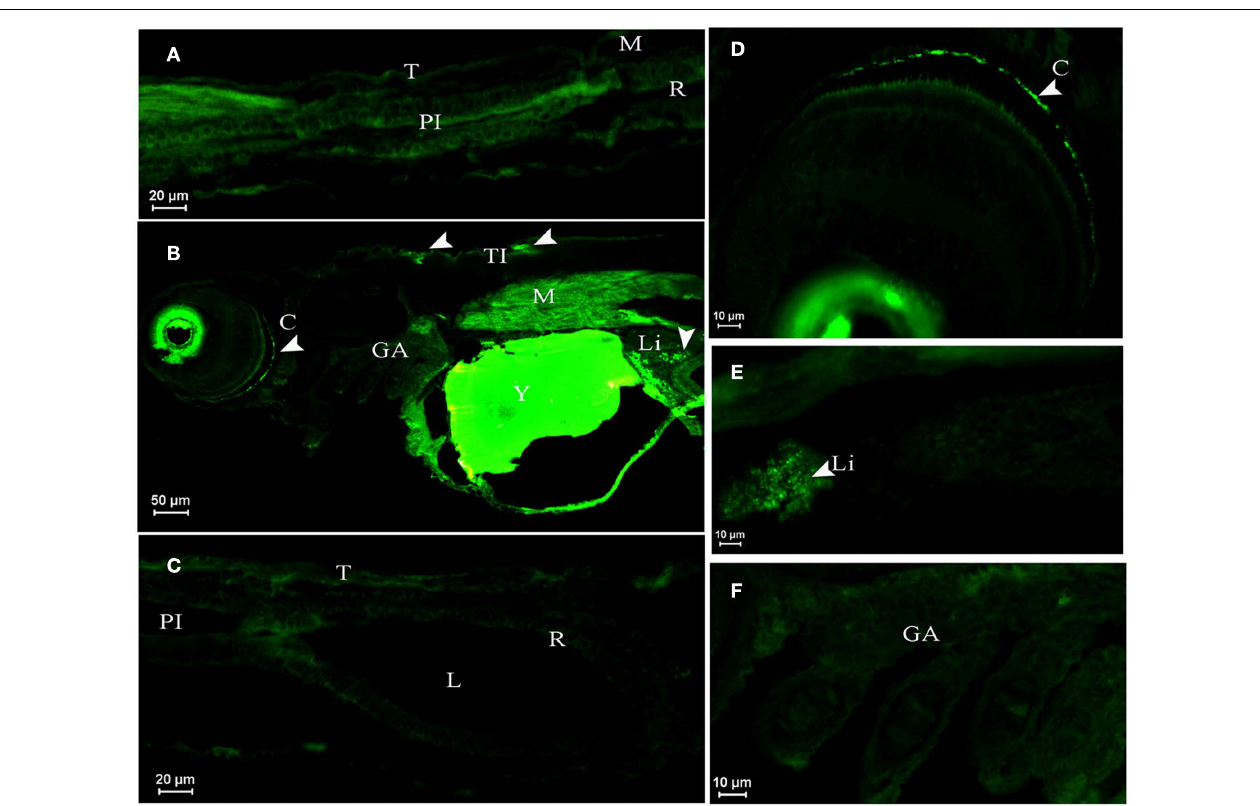
AQP1a is indicated by arrows). (D) Crystalline detail in a D3 larva. (E) Liver detail at D10. No fluorescence at D3 (F) in gills and (C) in digestive tract. C, crystalline; GA, gill arch; L, lumen; Li, liver; M, muscle; PI, posterior intestine; R, rectum;T, tegument;TI, tegumentary cell;Y; yolk; SW, sea water; DSW, diluted sea